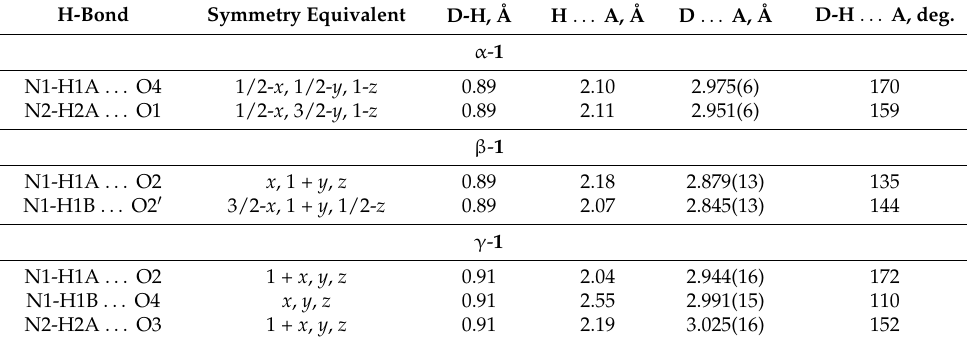
Table 3. Parameters of H-bonds in crystals of α - 1 , β - 1 and γ - 1